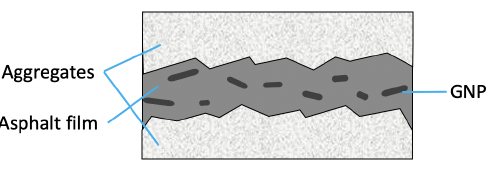
Figure 2. Scheme of the GNP-modified asphalt film between aggregate